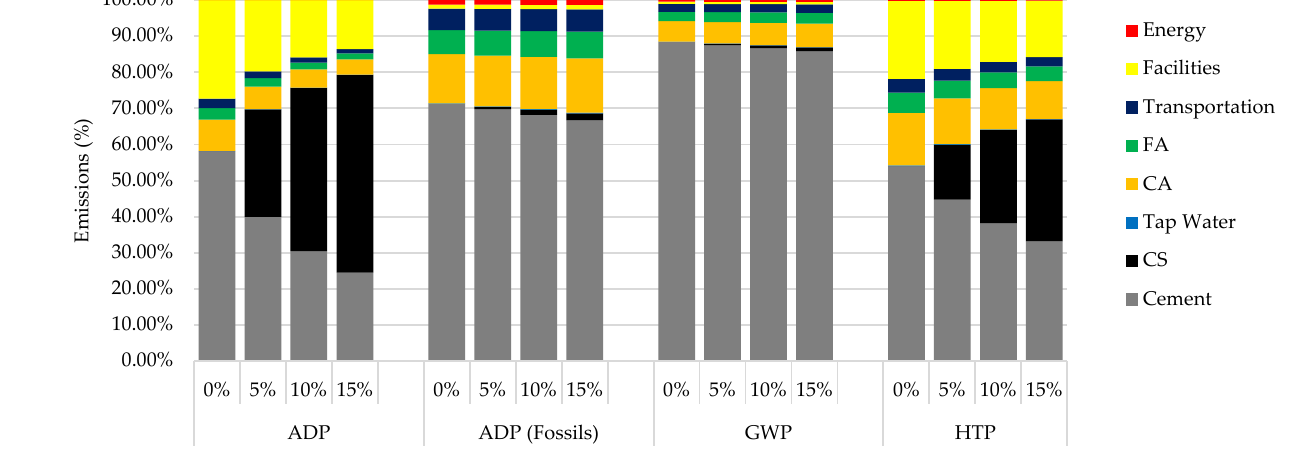
Figure 4. Disaggregation of impact assessment of 20.7 MPa concrete systems.